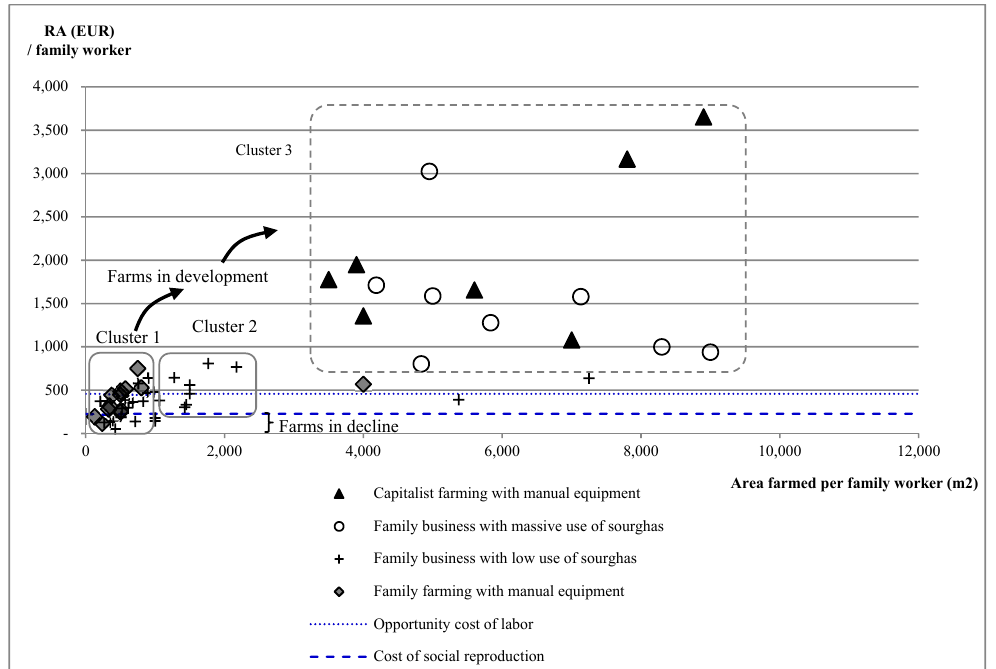
Figure 8. Comparative performance of manual production systems.